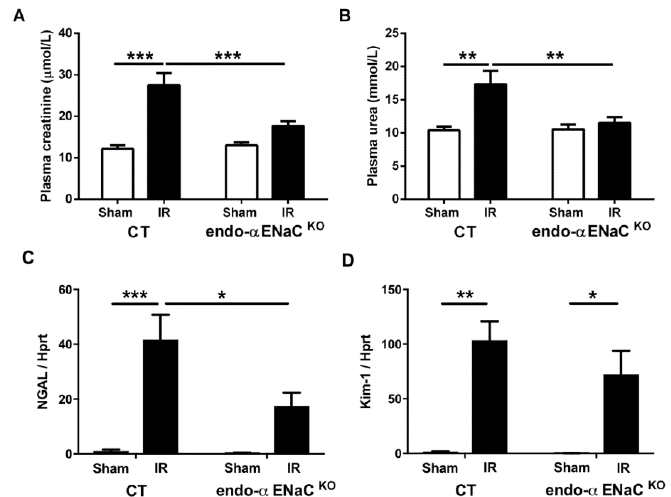
Figure 1. Endothelial sodium channel α ( αENaC ) deficiency protects against kidney injury induced by ischemia/reperfusion (IR). ( A ) Plasma creatinine and ( B ) plasma urea levels as indicators of the renal function. Whole kidney mRNA levels for ( C ) neutrophil gelatinase associated lipocalin-2 and ( D ) kidney injury molecule-1. Hypoxanthine guanine phosphoribosyltransferase (Hprt) expression was used as housekeeping gene for normalization. n = 8 per group. * p < 0.05, ** p < 0.01, and *** p < 0.001.